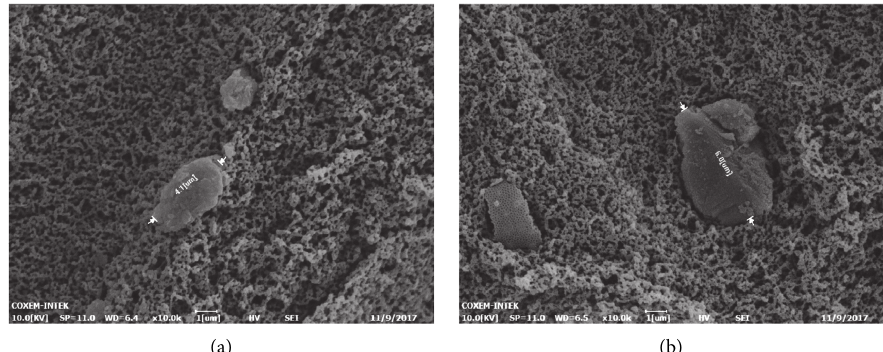
Figure 10: Effect of AgNPs in T. gondii oocyst morphology as assessed by SEM. In the control sample, intact oocyst (a), in the presence AgNPs for 45 min (b) and 60min (c).